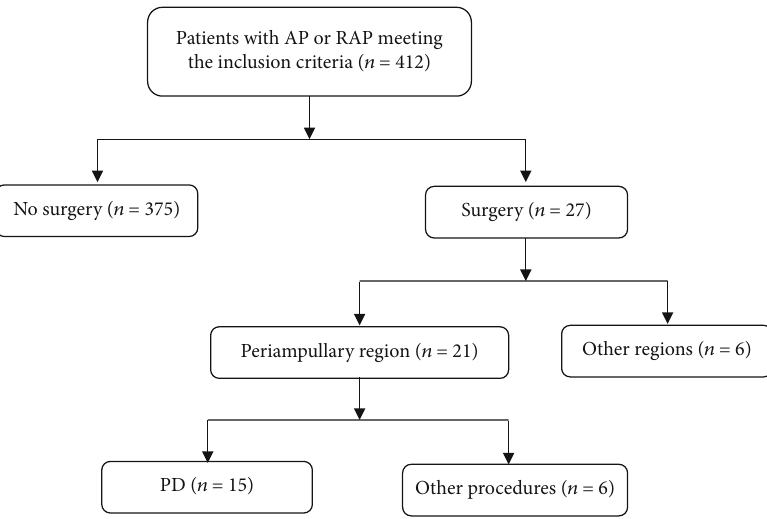
Figure 1: Flow chart depicting study design. Table 1: Demographic characteristics for patients in the study